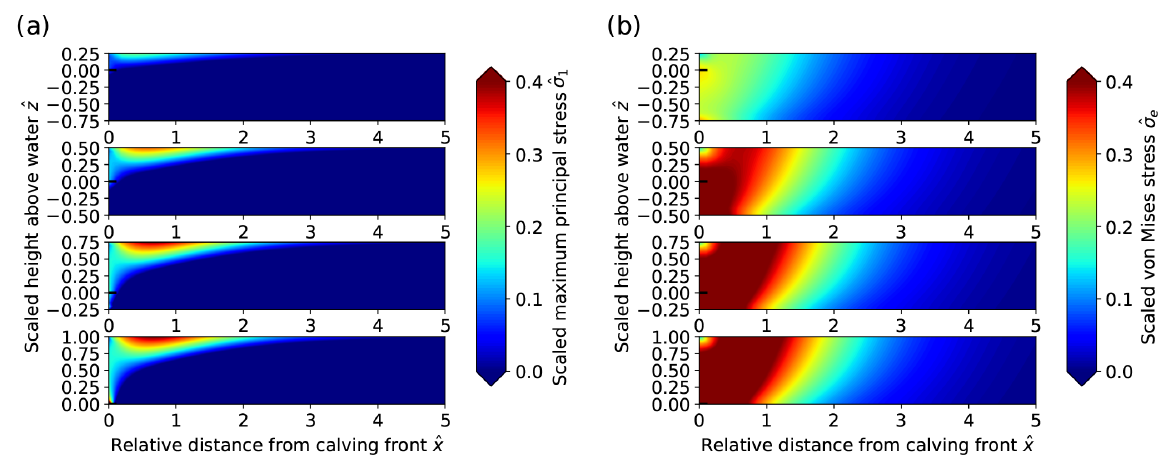
Figure B1. Stress distributions for varying water depth. (a) Scaled maximum principal stress distribution. (b) Scaled von Mises stress